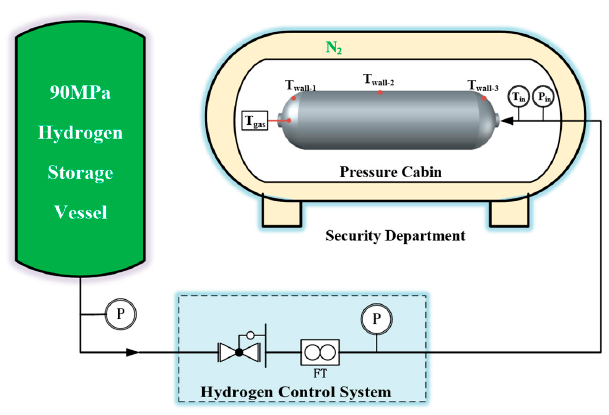
Figure 2. Flow chart of the experimental system.